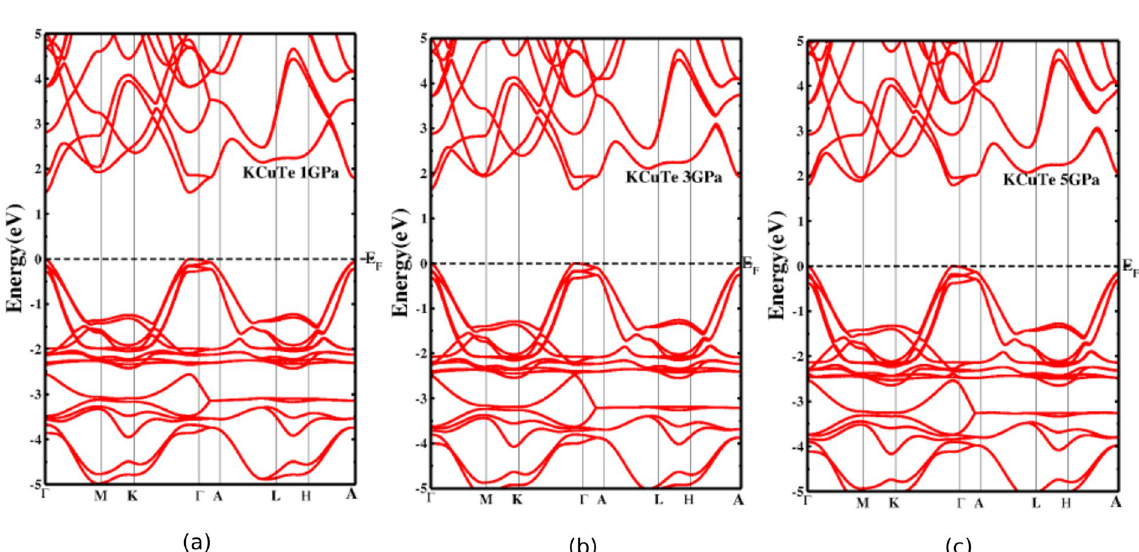
Figure 7. Effect of pressure on band structures of KCuTe at ( a ) 1 GPa ( b ) 3 GPa and ( c ) 5 GPa by using TBmBJ potential and incorporating